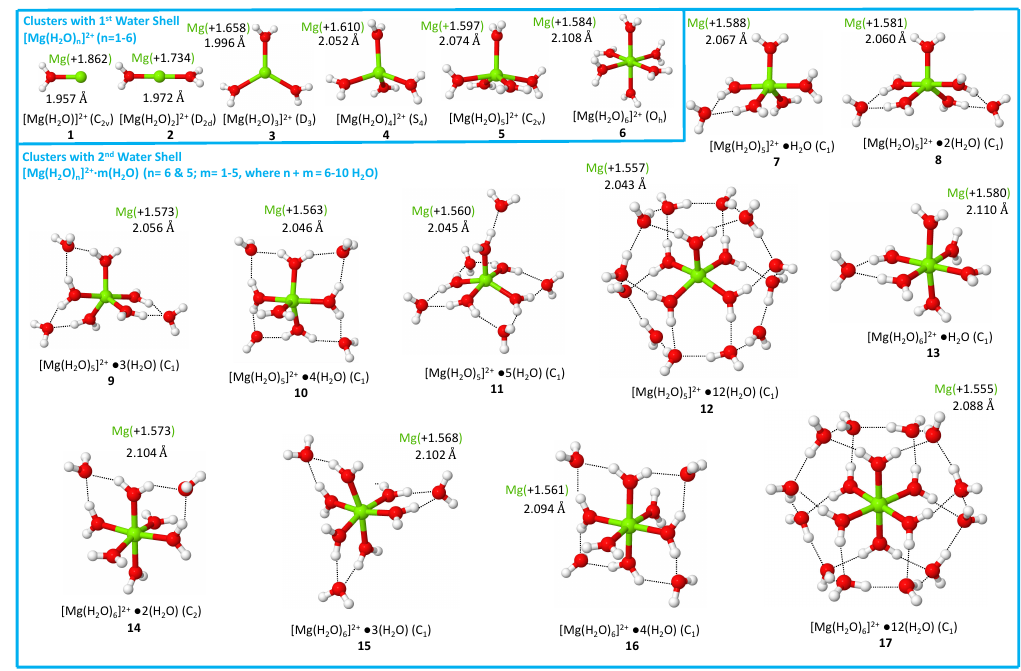
Figure 1. A summary of the natural bond orbital (NBO) charges of the Mg atom alongside average Mg–O bond distances for clusters 1 – 17 obtained at the ω B97X-D/6-311++G(d,p) level of